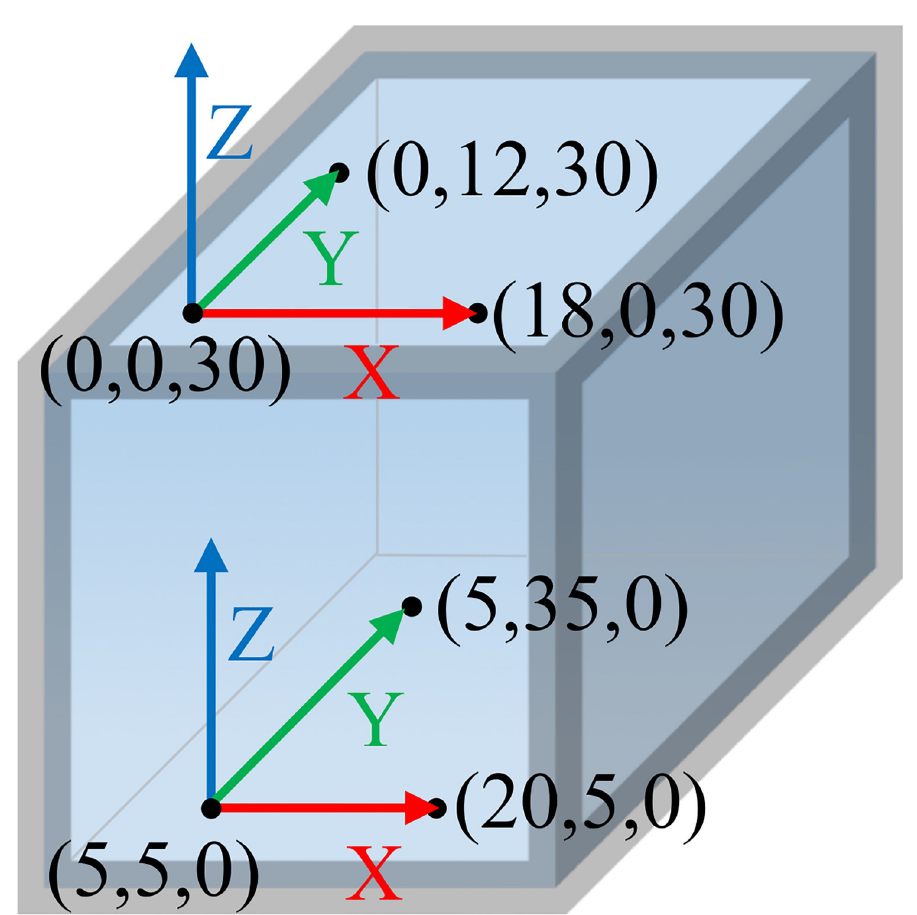
Fig 3. Validation block. Vertebral-sized, acrylic, validation block with tantalum beads and two associated coordinate systems. Dimensions/coordinates shown are in mm.